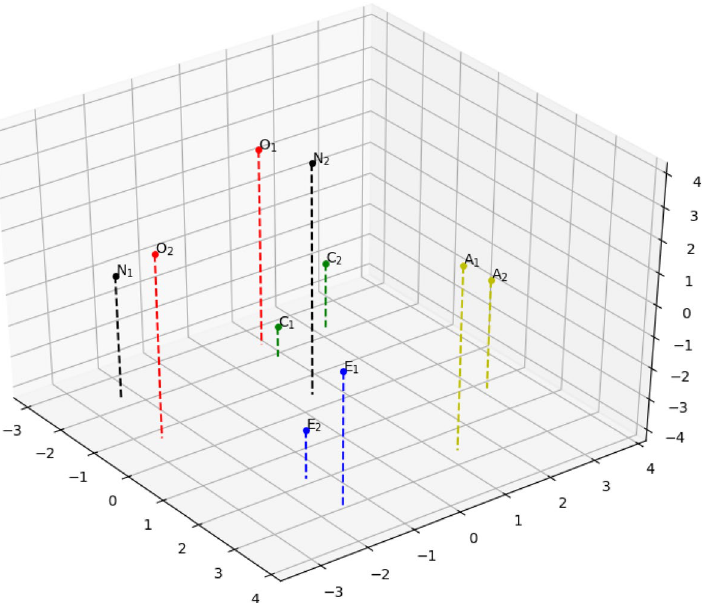
Figure 3. Multi-dimensional scaling (MDS) results for the learned joint importance profiles for personality traits on both the data sets. Number {1, 2} in the subscript denotes the dataset